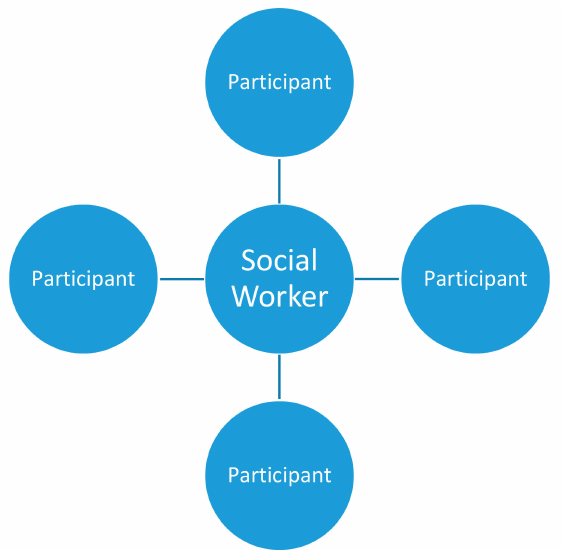
Figure 2. The relationship between social workers and